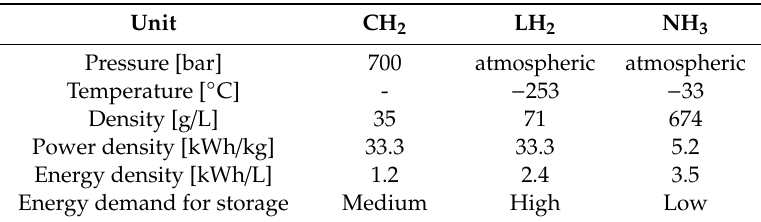
Table 1. Comparison between hydrogen and ammonia.